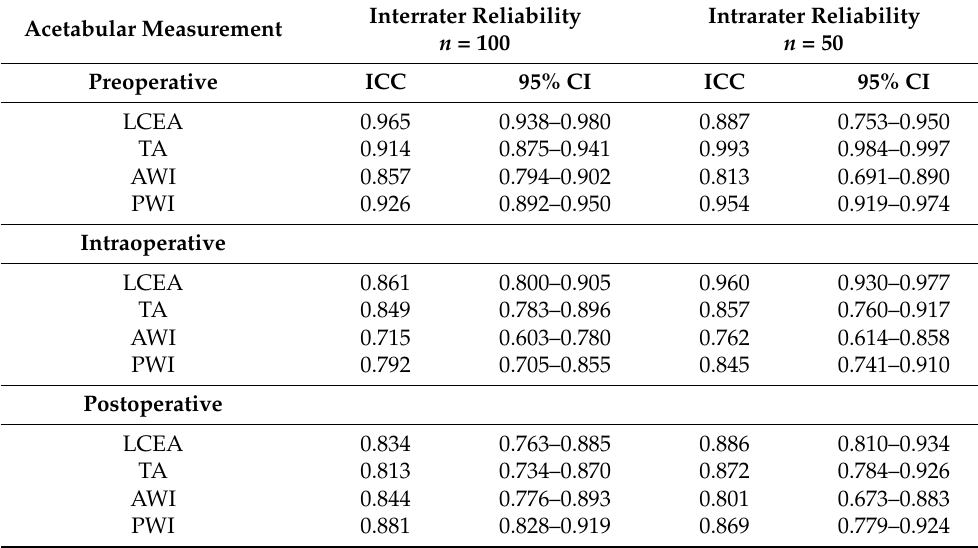
Table 3. Interrater and intrarater